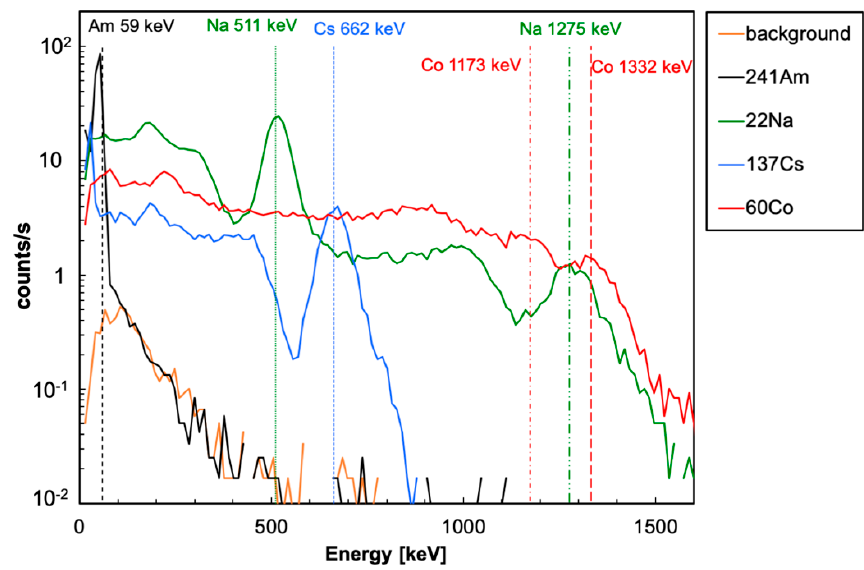
Figure 6. The energy spectra for the gamma sources of Table 1, placed at a 2 cm distance from the detector, and the background. Each spectrum was acquired in 120 s.